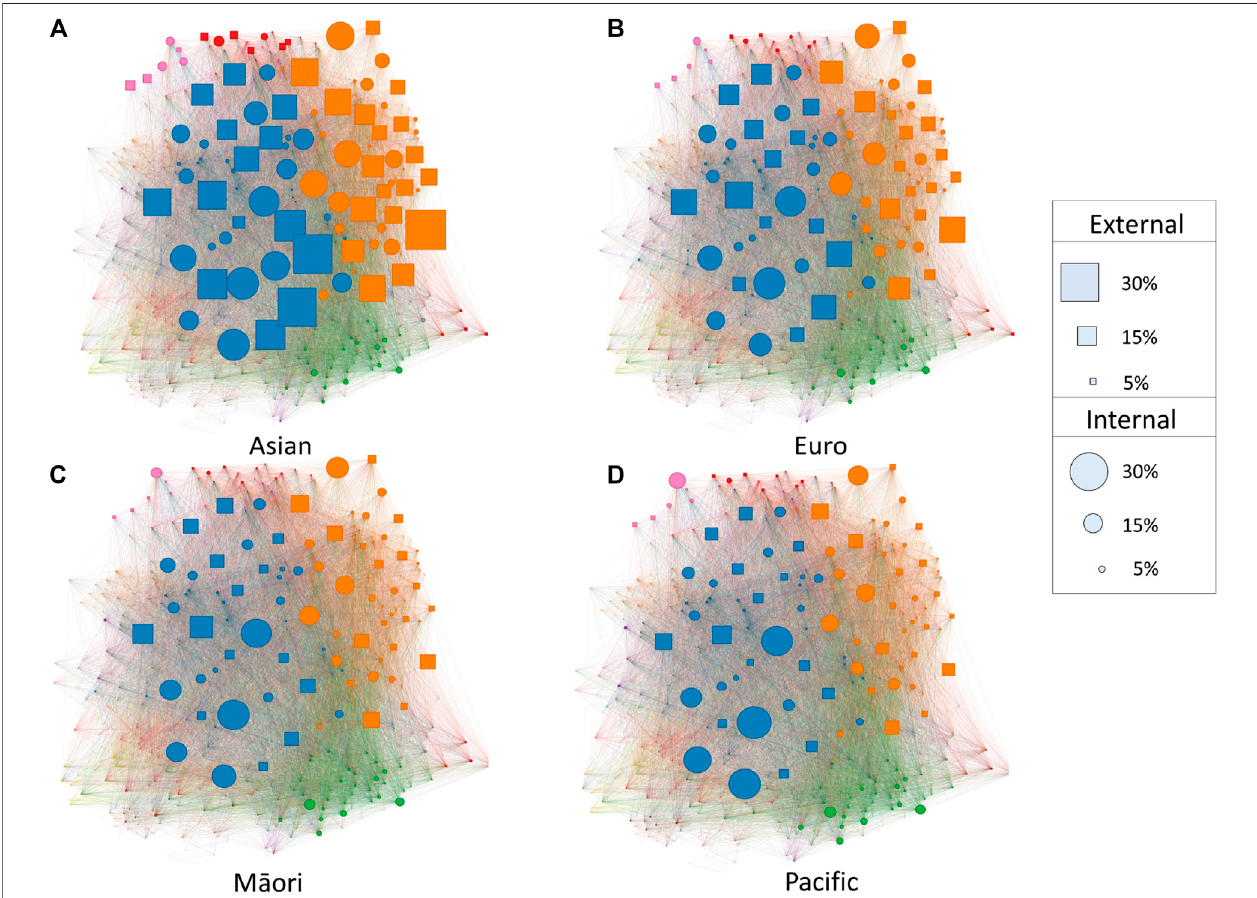
FIGURE 9 | Network of NCEA Level 3 Standards by Ethnicity. The standard projection of the NCEA Level 3 standard co-enrolment network by ethnicity across all years. Node size represents the percentage of students within the sub-population who were enrolled in a standard, color represents community membership, squared nodes representexternallyassessed standards, and circularnodes representinternally assessed standards. Forallethnic groupsub-populations, themain scienceand mathematics communities (orange and blue nodes) tended to have higher probabilities of enrollment. The propensity for science and mathematics standard enrollment was especially true for Asian students, and less true M (cid:2) aori (C) and Paci fi c Island (D) groups.